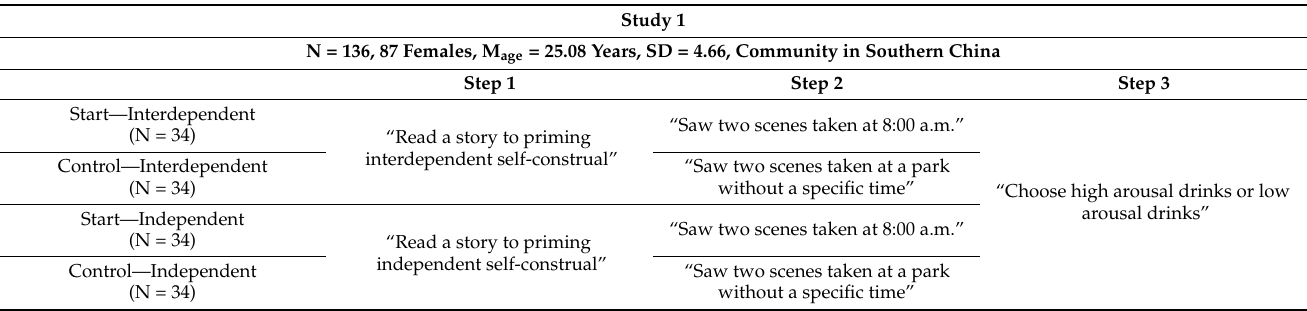
Table 2. Participants and procedure in Study 1.